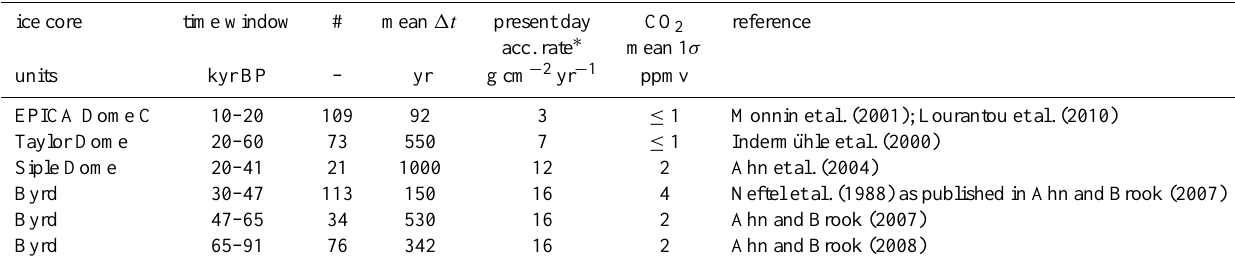
Table 1. Available high resolution ice core CO 2 records over the last glacial cycle in comparison to the EPICA Dome C data covering Termination